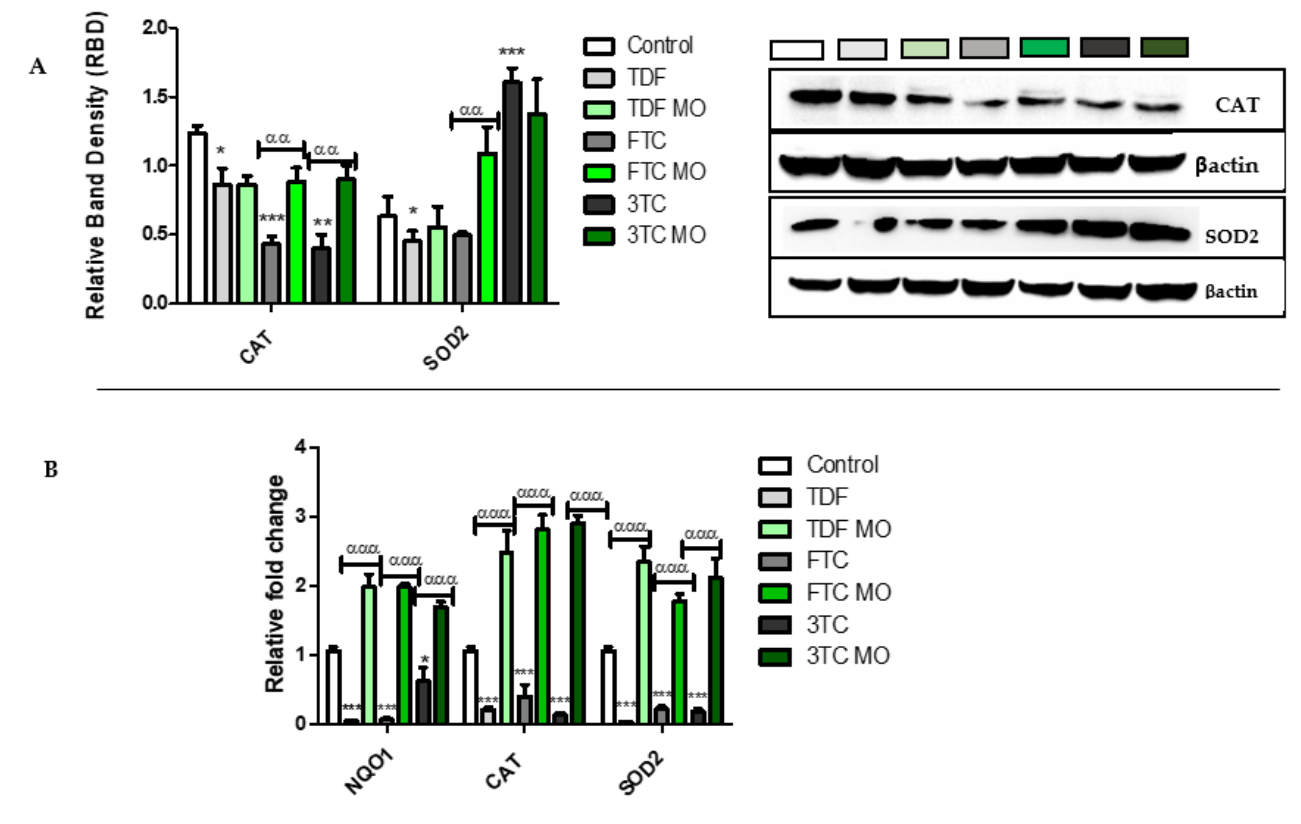
Figure 6. Assessment of antioxidants CAT, SOD2, and NQO1 expression post-ARV and post-ARV MO treatment. ( A ) CAT was significantly decreased by TDF, FTC, and 3TC while significantly increased by MO. SOD2 was significantly decreased by TDF and FTC and increased by 3TC. MO significantly increased SOD2 expression at TDF and FTC; however, there was a slight decrease in MO and 3TC treated cells ( B ) The CAT, SOD2, and NQO1 mRNA was significantly decreased by TDF, FTC, and 3TC while increased by the addition of MO. * Represents a significant difference between the control and ARV (*, p < 0.05, **, p < 0.001 and ***, p < 0.0001). α Represents a significant difference